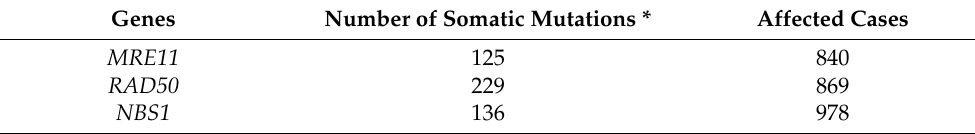
Table 1. Summary of total cancer-associated mutations in each component of MRN complex. Genes Number of Somatic Mutations * Affected